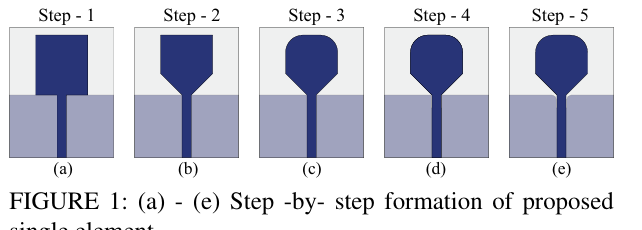
FIGURE 1: (a) - (e) Step -by- step formation of proposed single element.